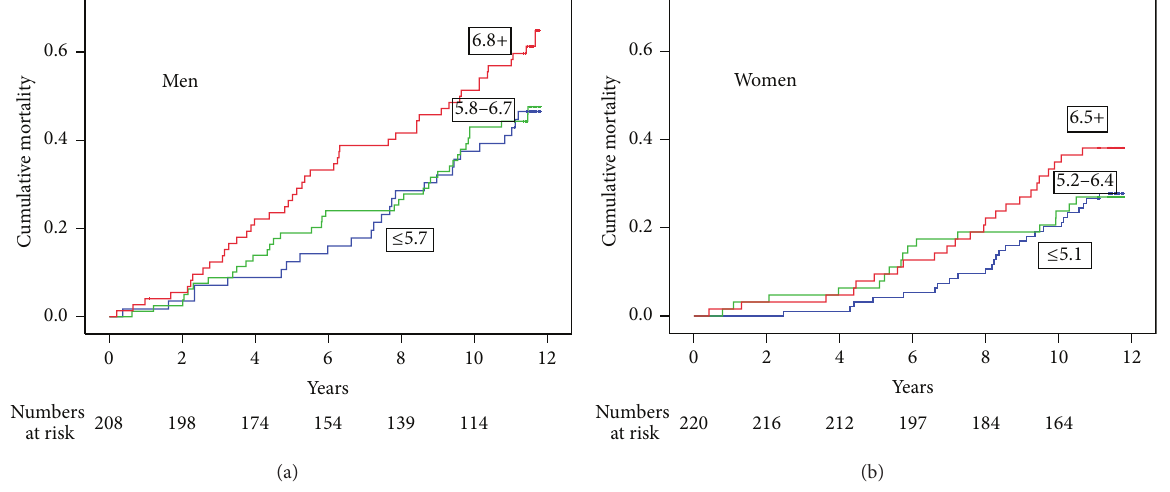
study demonstrated a mean WBC count slightly on the rise in those above 65 years of age